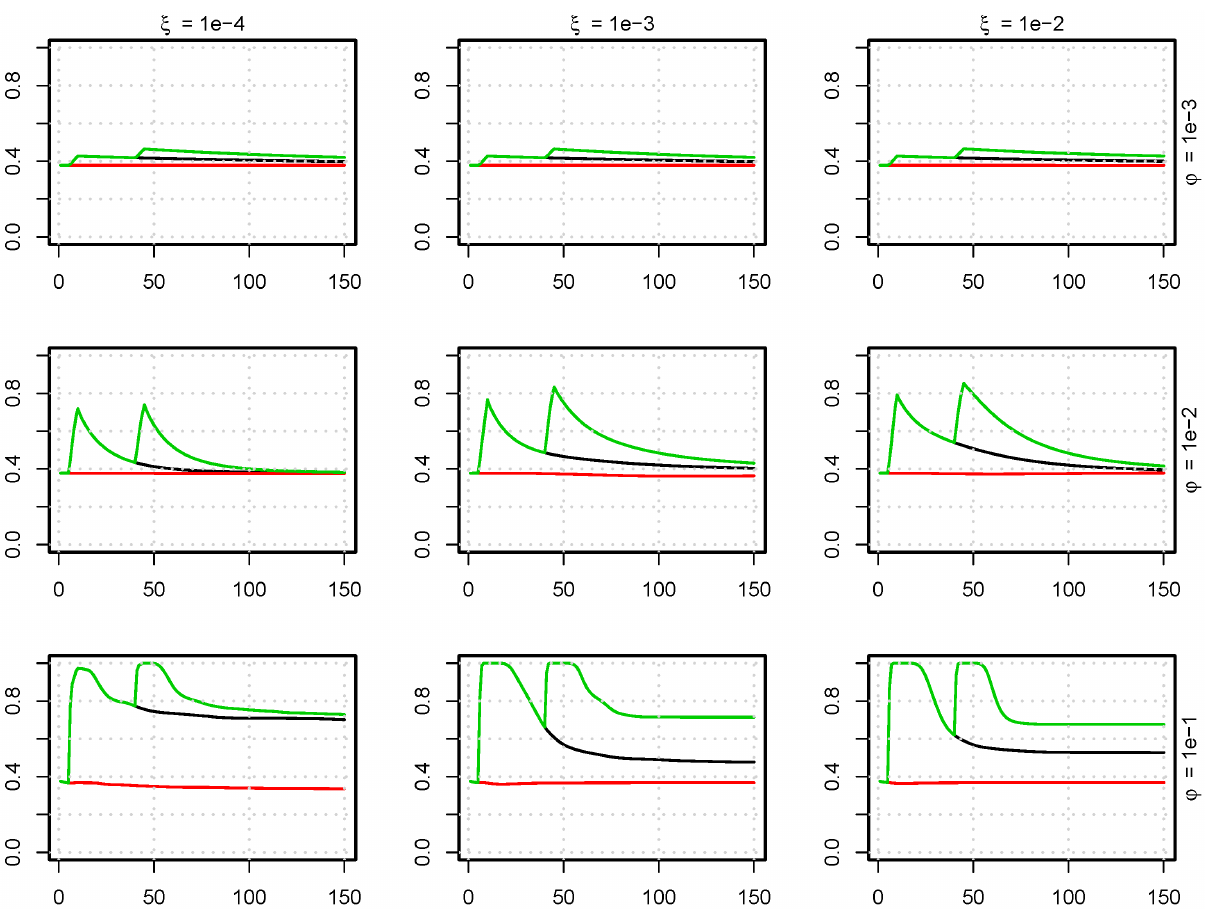
Figure 6. The influence of AMT on the level of resistant strains. Fraction of antimicrobial resistant bacteria (y-axes) as a function of time [days] (x-axes) with antimicrobial treatment. The time of AMT is indicated by color: red: no treatment, black: treatment from day 5 to 10, green: additional treatment day 35 to 40. This is modelled for nine parameter sets of Q (excretion rate) and j (uptake fraction from the environment). ( n R ~ 30 ).